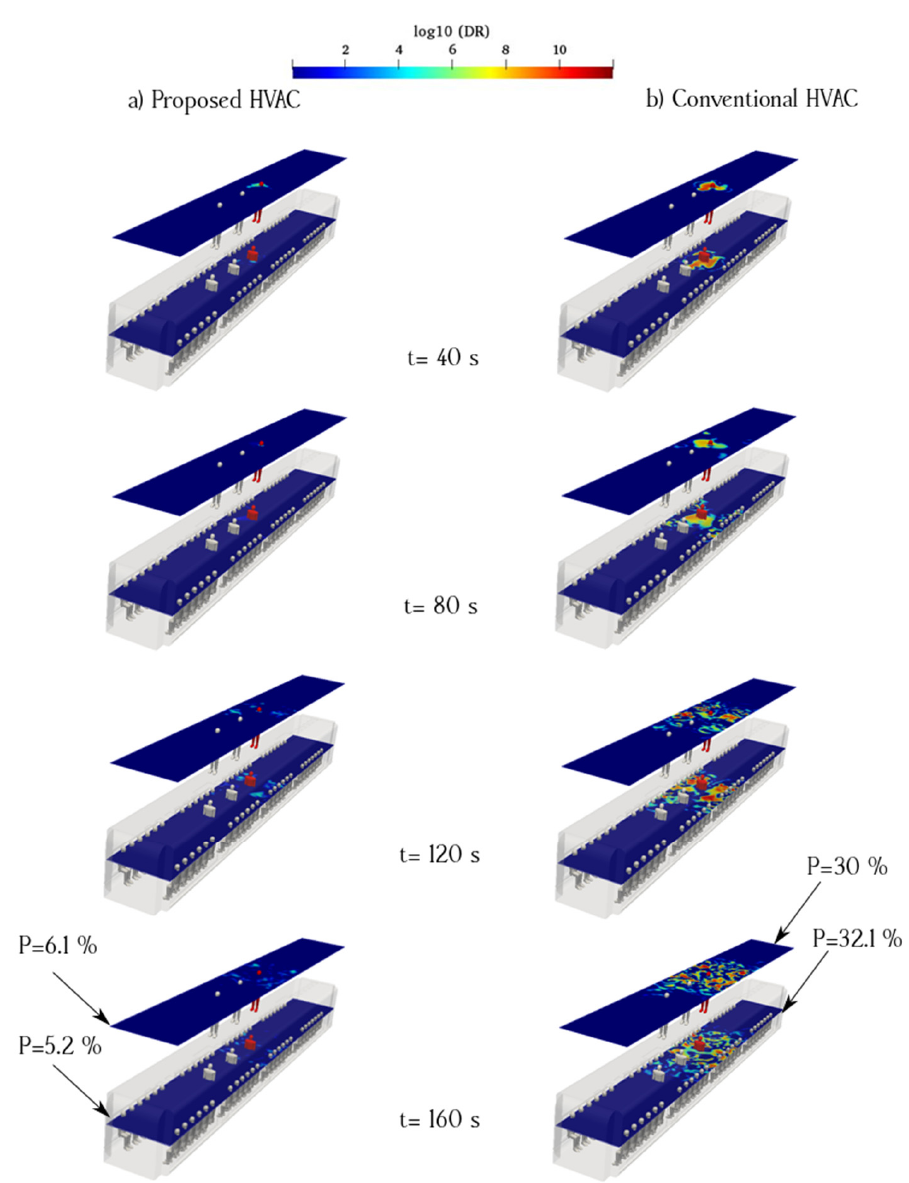
Figure 9. Time evolution of the counters of log 10 (DR) when the infected individual was standing near the supply and recirculated air ducts of the proposed ( a ) and conventional ( b ) HVAC systems (Case 1).